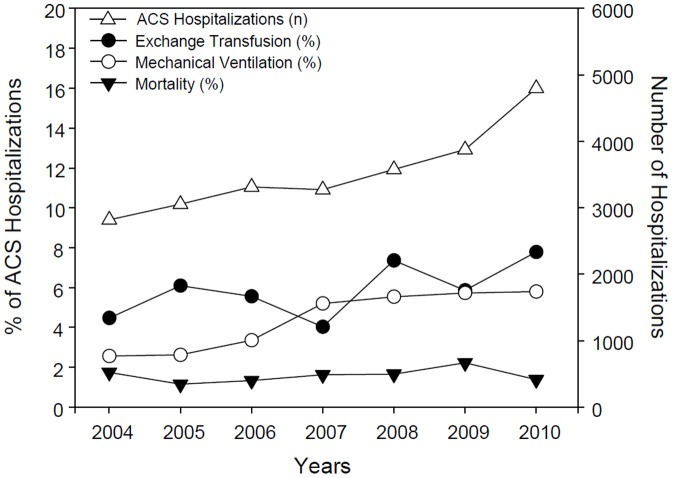
Acute Chest Syndrome Hospitalizations and Outcomes per year.The descriptive figure shows the number of acute chest syndrome hospitalizations per year- identified by “n” (2004 to 2010)- Right y axis. Outcomes such as Exchange transfusion(%), Mechanical Ventilation(%) and Mortality(%) are shown as percentages of acute chest syndrome hospitalizations.(2004 to 2010)- Left y axis.